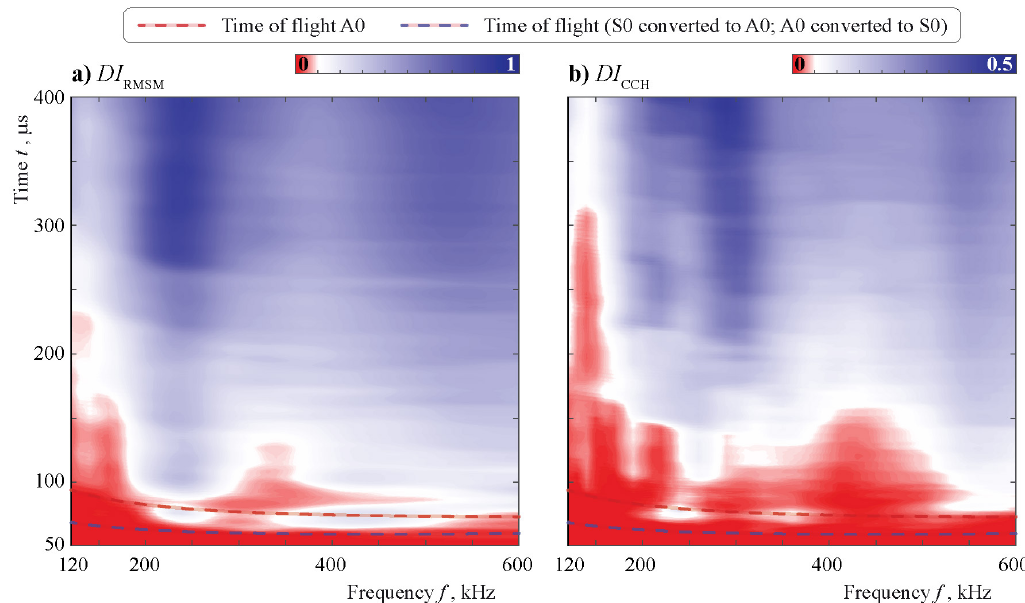
Figure 18. The damage index (DI) DI m ( f , t ) calculated using the data from a sensor at different central frequencies f in the case of an obstacle with a 25% debonding